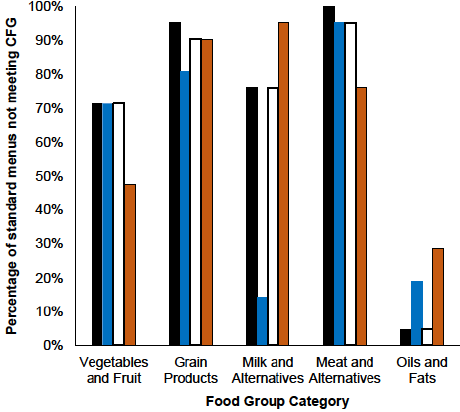
Figure 1. Percentage of standard hospital menus not meeting Canada’s Food Guide recommended number of servings.